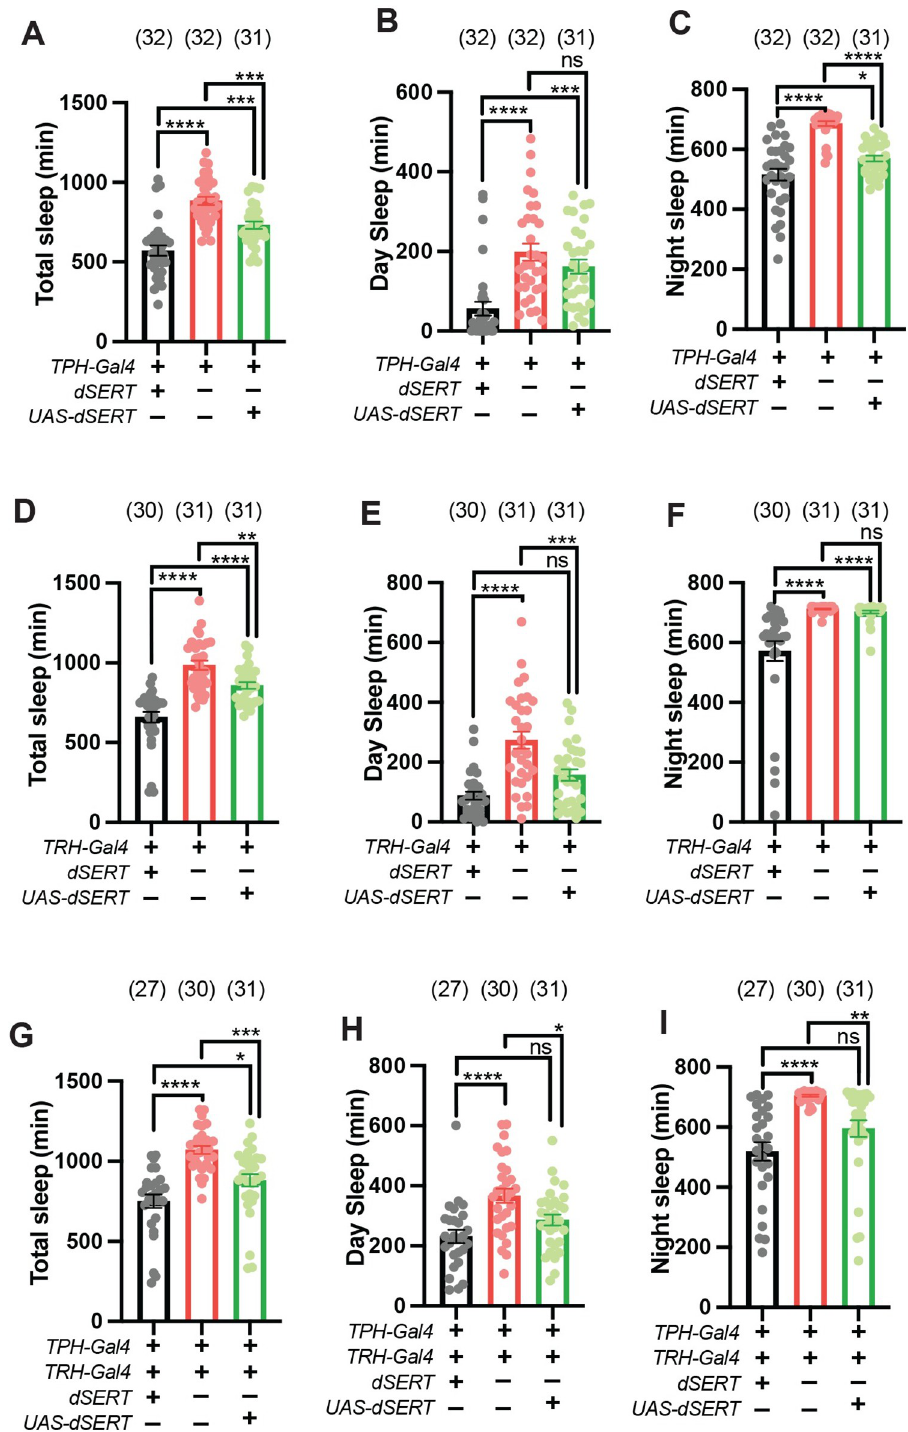
Fig 7. Transgenic expression of dSERT with both “ TPH”-Gal4 and TRH-Gal4 is sufficient to rescue increased sleep in dSERT 16 mutants. (A-C) Quantification of total sleep (A), daytime sleep (B) and nighttime sleep (C) in control w 1118 ;TPH-Gal4 (grey), w 1118 ;TPH-Gal4 , dSERT 16 (red), and w 1118 ;TPH-Gal4 , dSERT 16 ; UAS-dSERT (green) flies. (D-F) Quantification of total sleep (D), daytime sleep (E), and nighttime sleep (F) in w 1118 ;TRH-Gal4 (grey), w 1118 ;dSERT 16 ; TRH-Gal4 (red), and w 1118 ;dSERT 16 ; TRH-Gal4/UAS-dSERT (green) flies. (G-I) Quantification of total